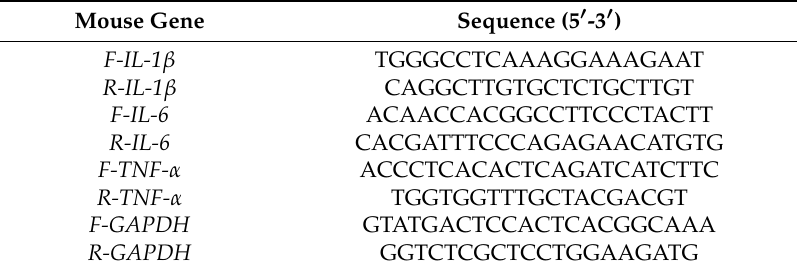
Table 1. Sequences of the primers for real-time